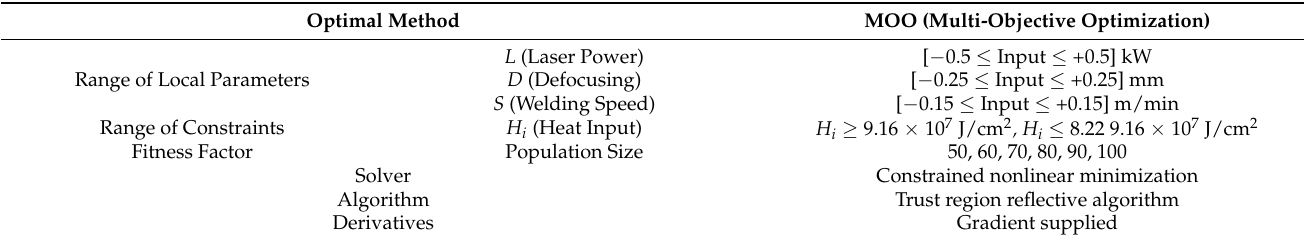
Table 13. Multi-objective optimization algorithm parameters and their values.